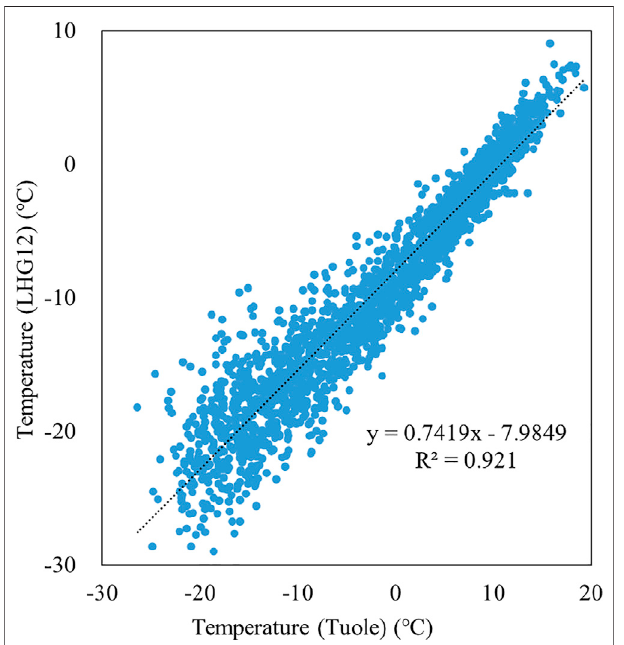
FIGURE7| Statisticsofpositiveand negativetemperature, 1957 –